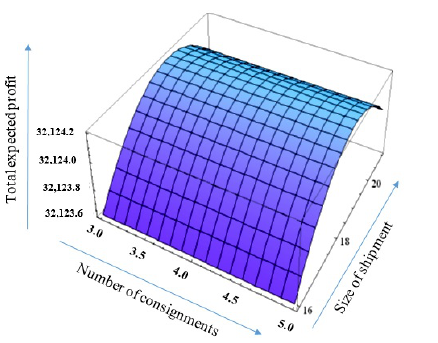
Figure 5. Total Expected Profit (TEP) versus number of consignments and size of